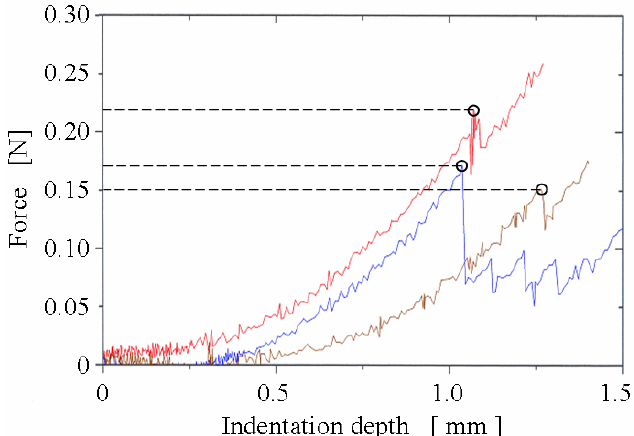
Figure 6. Static indentation curves of imitation skin. Indentation speed was 0.05 mm a minute